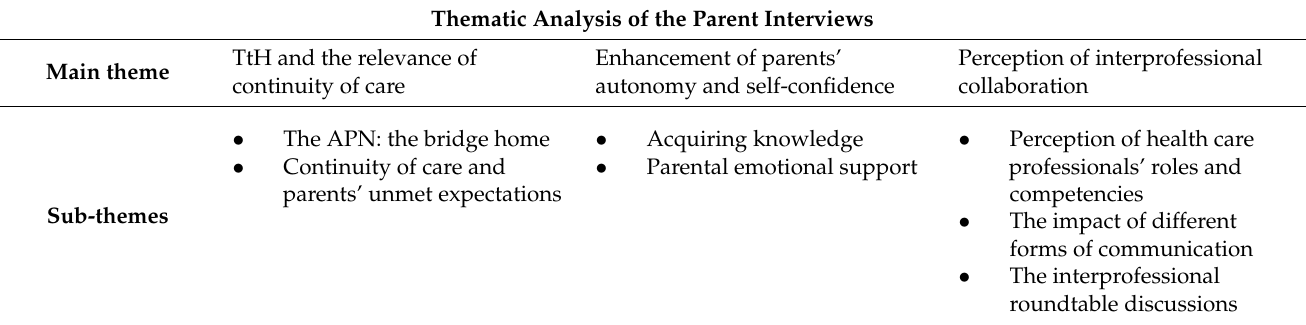
Table 3. Results of the thematic analysis of the parent